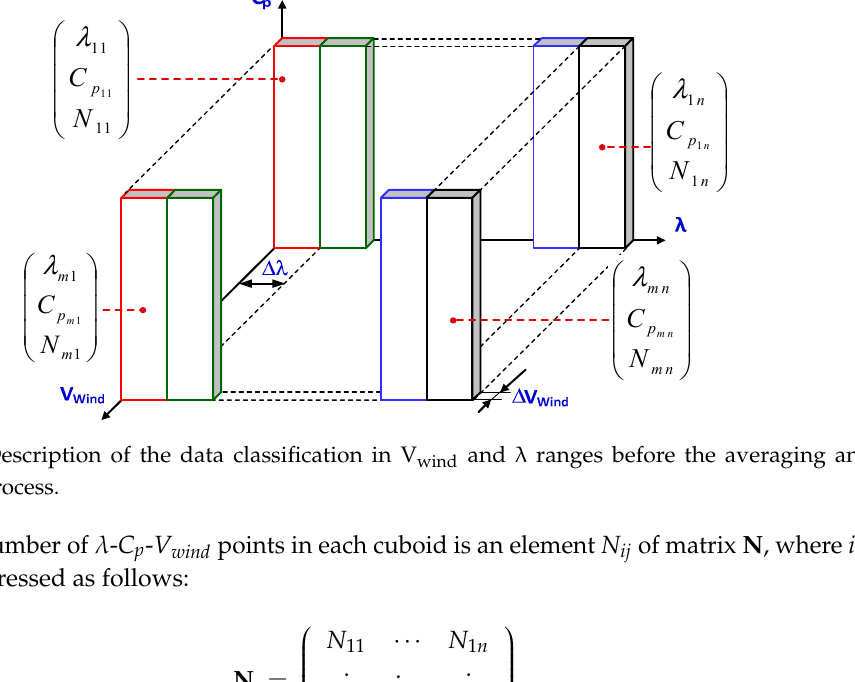
Figure 4. Raw experimental data obtained from the wind turbines.